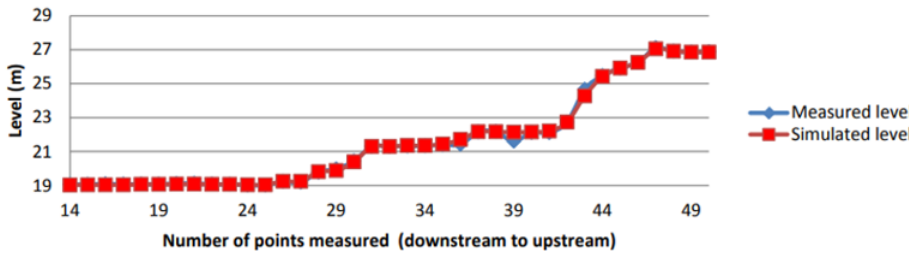
Figure 3. Profile of measured and simulated levels for 6 May 2011.